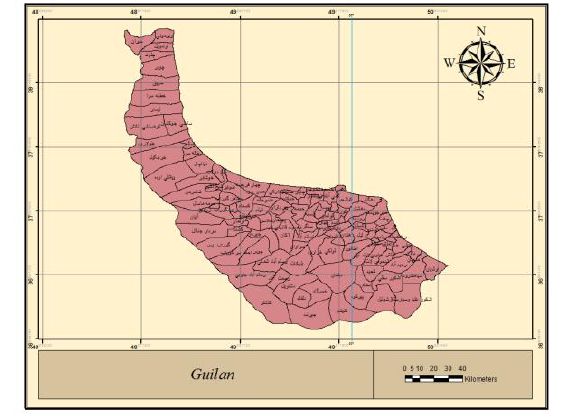
Figure 1. Guilan province and rural